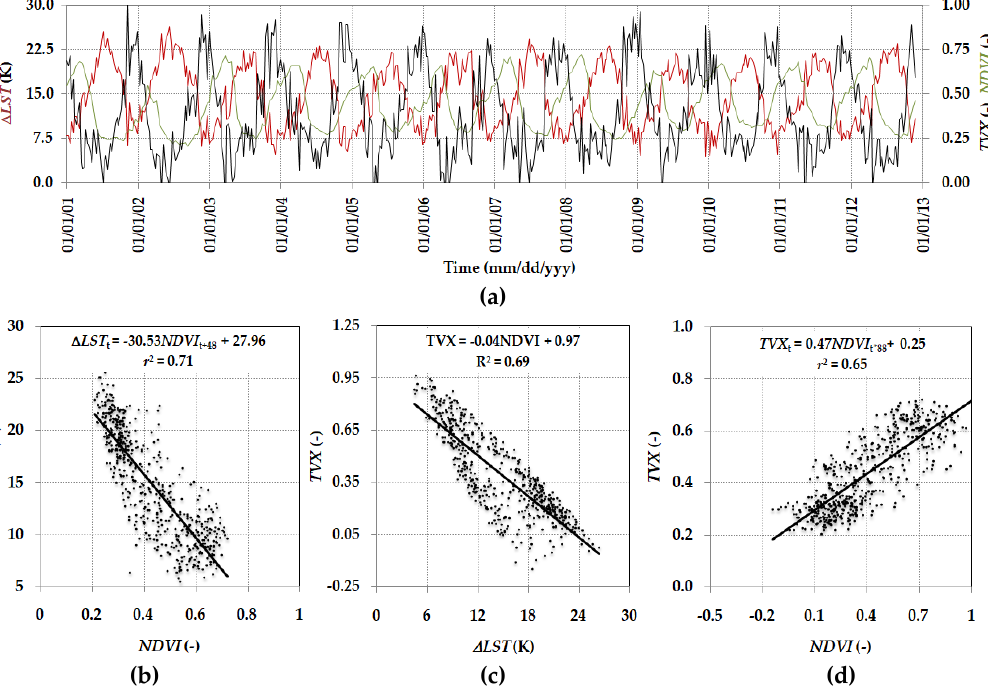
Figure 9. Time series of ( a ) ∆ LST (red line, principal y -axis), NDVI and TVX (green and black lines respectively, secondary y -axis) at Drasi. Scatterplot between ( b ) time shifted NDVI vs. ∆ LST ; ( c ) ∆ LST vs. TVX; ( d ) time shifted NDVI vs. TVX.